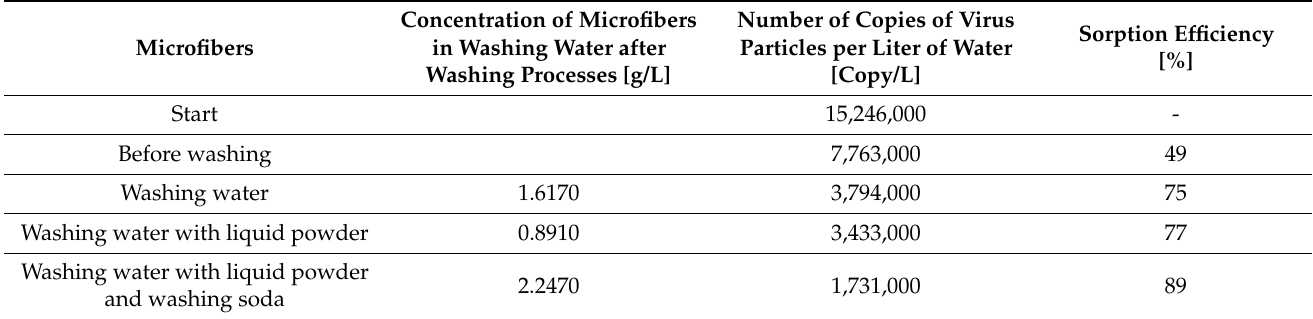
Table 2. The efficiency of sorption of virus particles on the surface of